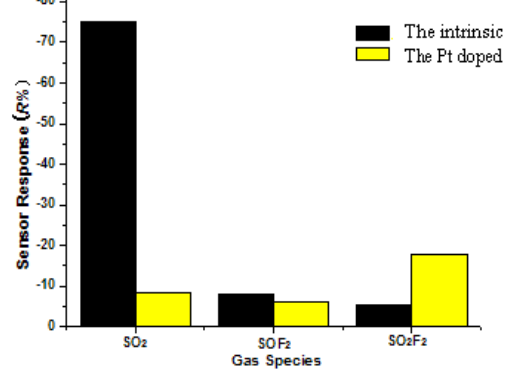
NTs to different SF decomposition 2 6